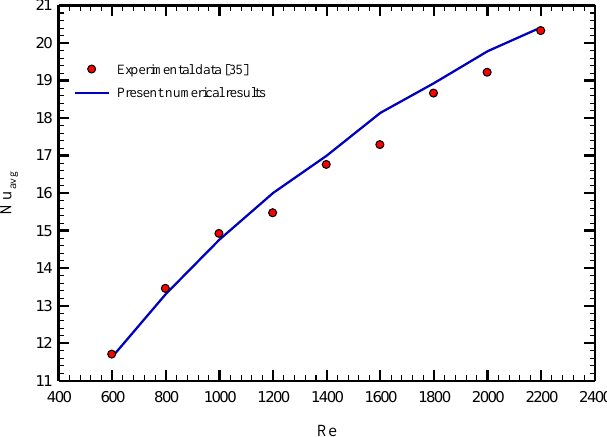
Figure 3. Validation results with the study of Qi et al. [35]. Reproduced with permission from [35].